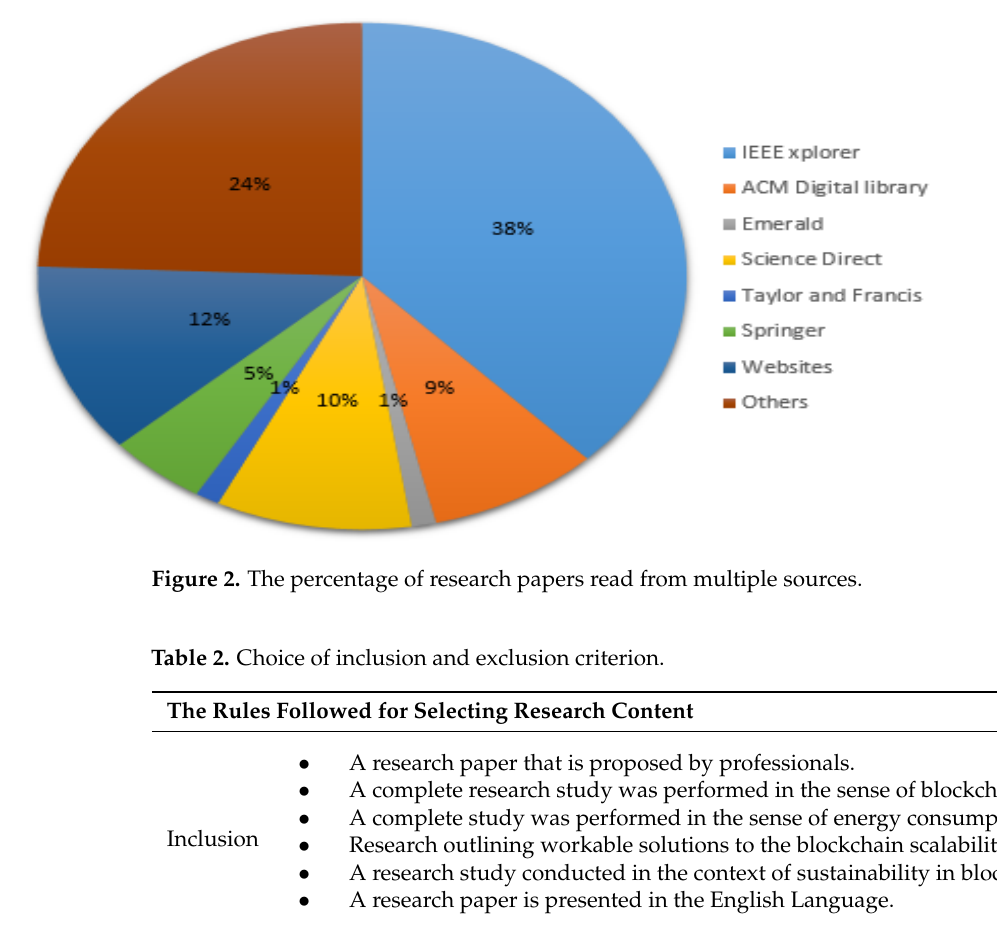
Table 2. Choice of inclusion and exclusion criterion.